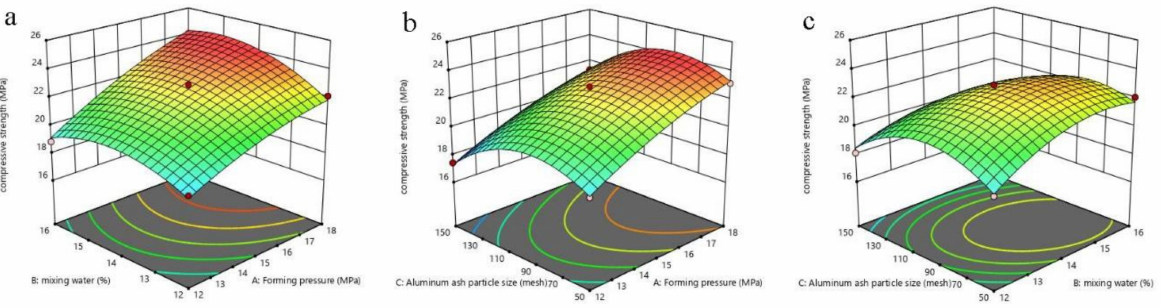
Figure 14. ( a ) Interaction response surface between forming pressure and mixing-water amount; ( b ) the interaction response surface between forming pressure and aluminum dross particle